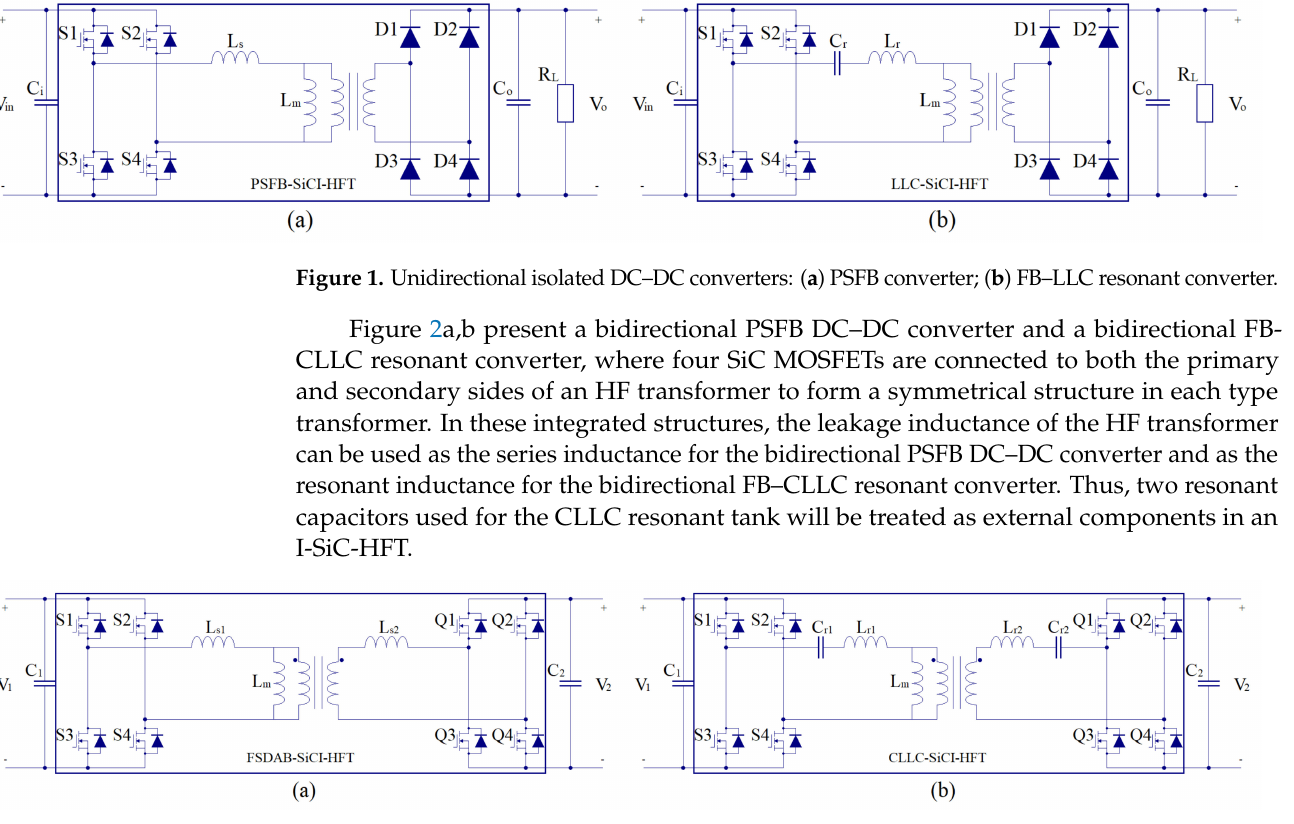
Figure 2. Bidirectional isolated DC–DC converters: ( a ) PSFB converter; ( b ) FB-CLLC resonant